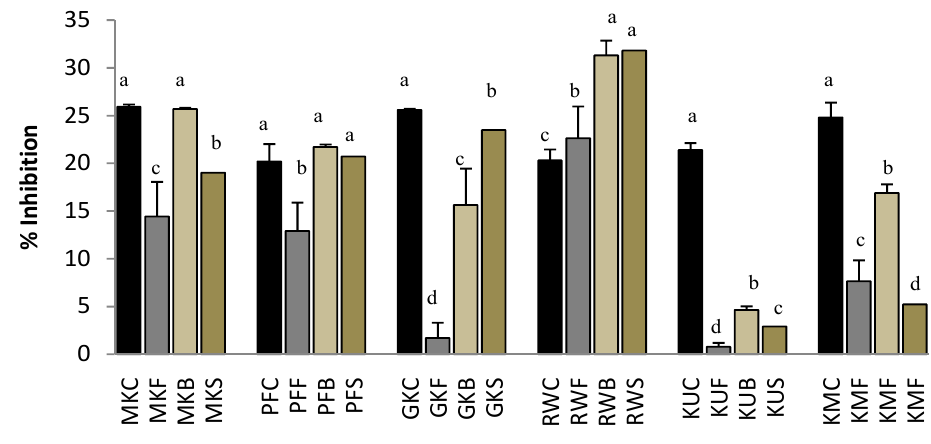
Figure 4. Proteinase inhibition ability of raw and cooked extracts of some GLV. Values represent means of triplicate readings. MK, O. zeylanica ; RW, C. auriculata ; KM, S. grandiflora ; KU, G. lactiferum ; PF, P. edulis ; GK, C. asiatica . C-fresh leaves; F-fried; B-boiled; S-steamed. Data are presented as means ± standard deviations of three replicate determinations. Columns with different letters for each vegetable are significantly different ( p < 0.05).